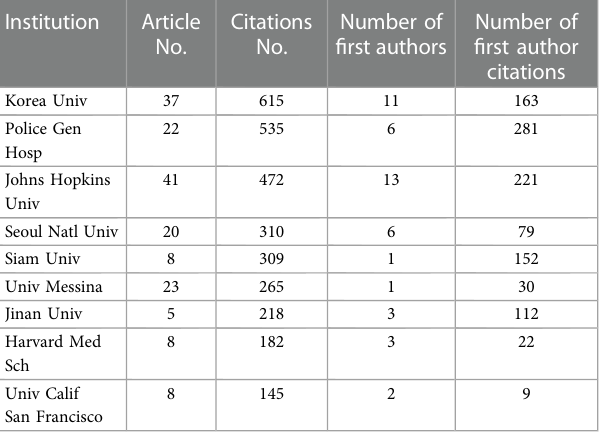
TABLE 1 Top 10 contributing institutions to the article about